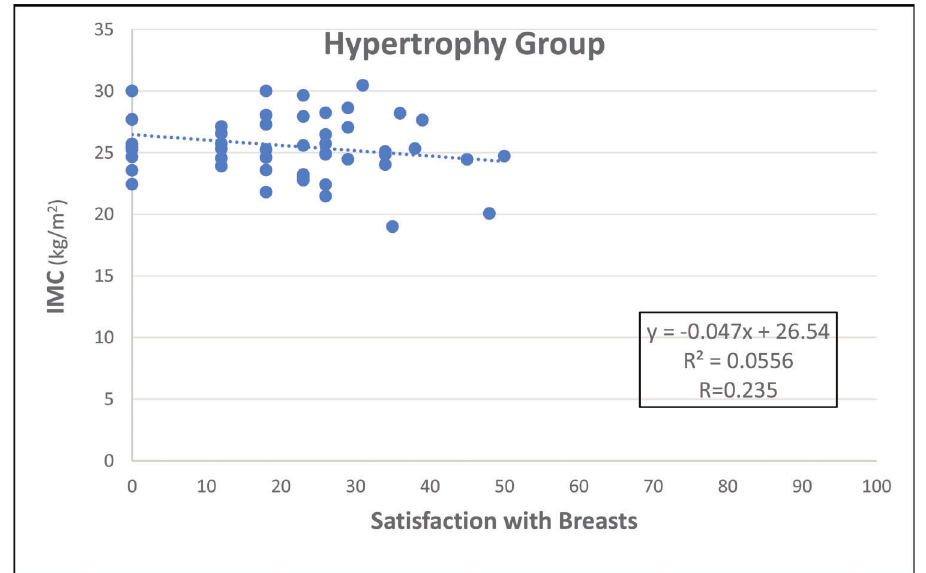
Figure 3 - Simple linear regression for BMI (independent variable) and ‘‘ Satisfaction with breasts ’’ (dependent variable) in the